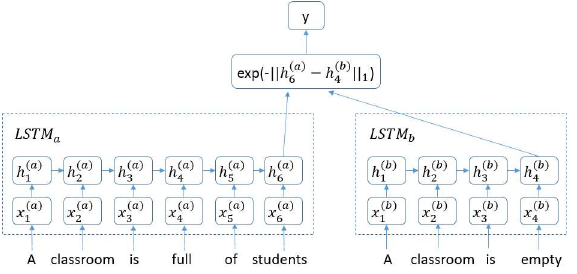
Fig 1. MaLSTM model. The MaLSTM use a LSTM to read in word-vectors that represent each input sentence and employs its final hidden state as a vector representation for each sentence. The similarities among these representations are employed as predictors of semantic